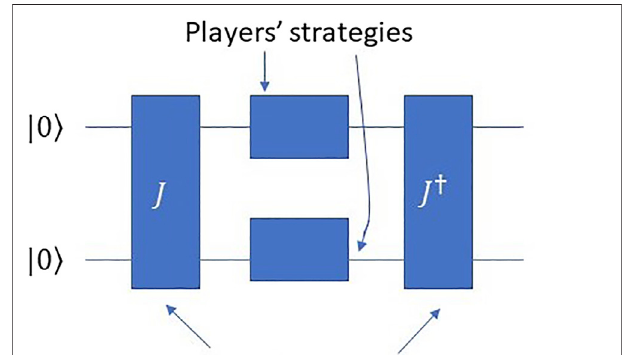
FIGURE 3 | The quantum circuit implementation of the EWL quantum game protocol. The referee consists of two quantum logic gates, J , which entangles the two qubits, and its inverse, J † . In the middle of these two operations are the players ’ independent quantum strategic choices that each of them enacts on her qubit as unitary operations. We assume the top qubit is Player I ’ s and the second one is Player II ’ s.